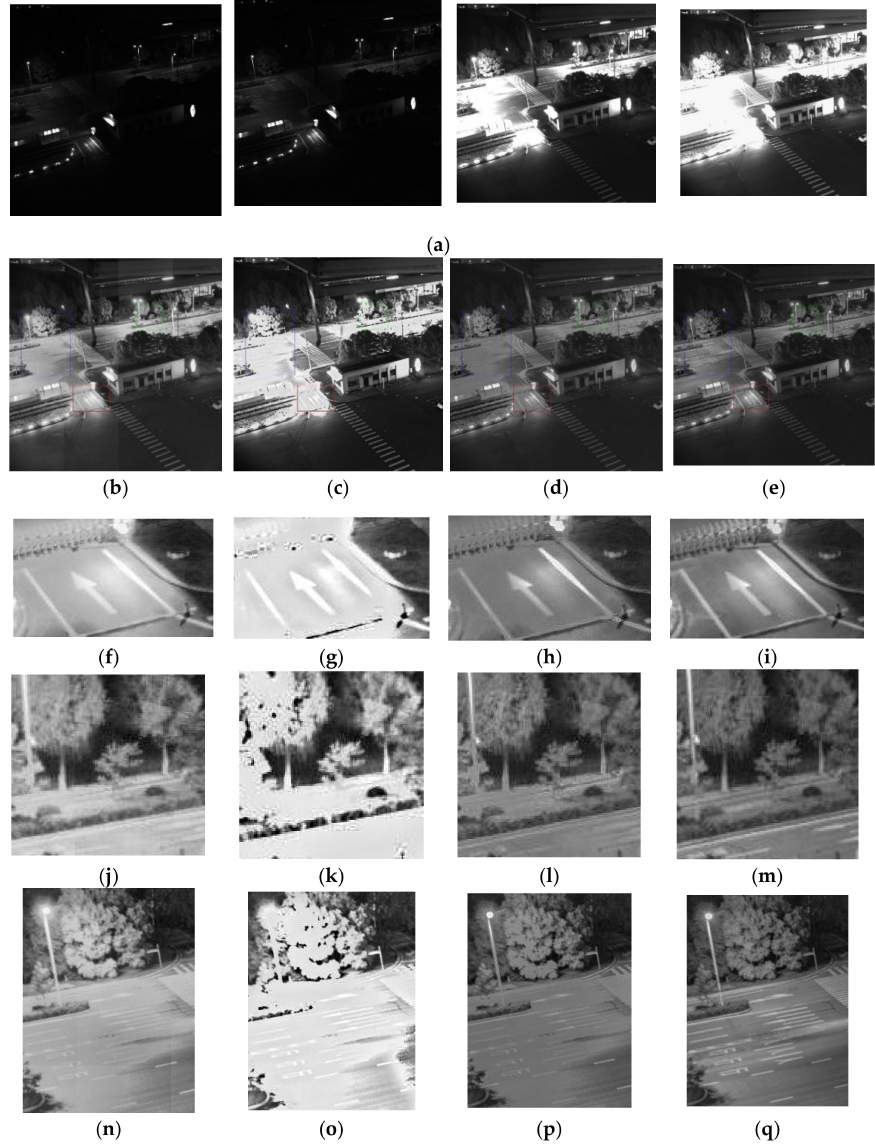
Figure 7. Comparison of different methods for the outdoor roads. ( a ) Source image sequence. ( b ) The fusion image of [16]. ( c ) The fusion image of [29]. ( d ) The fusion image of [15]. ( e ) The fusion image by our method. ( f ) The local image of by [16]. ( g ) The local image of [29]. ( h ) The local image of [15]. ( i ) The local image by our method. ( j ) The local image by [16]. ( k ) The local image by [29]. (l) The local image by [15]. ( m ) The local image by our method. ( n ) The local image by [16]. ( o ) The local image by [29]. ( p ) The local image by [15]. ( q ) The local image by our